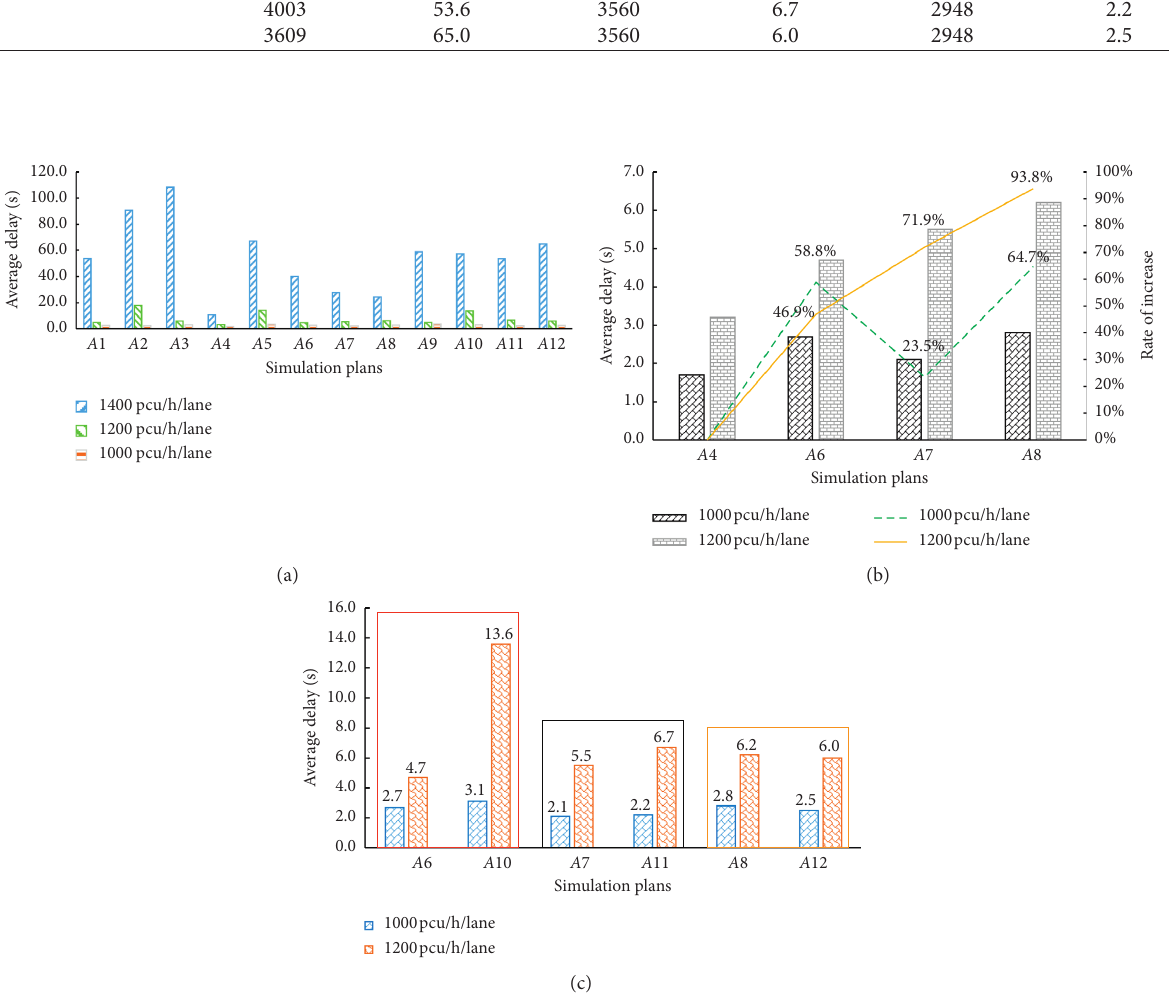
Figure 5: Results comparison among lane-changing plans: (a) the twelve lane-changing plans, (b) unified lane-changing and stepped lane- changing, and (c) lane-changing paths with flows of 1000pcu/h/lane and